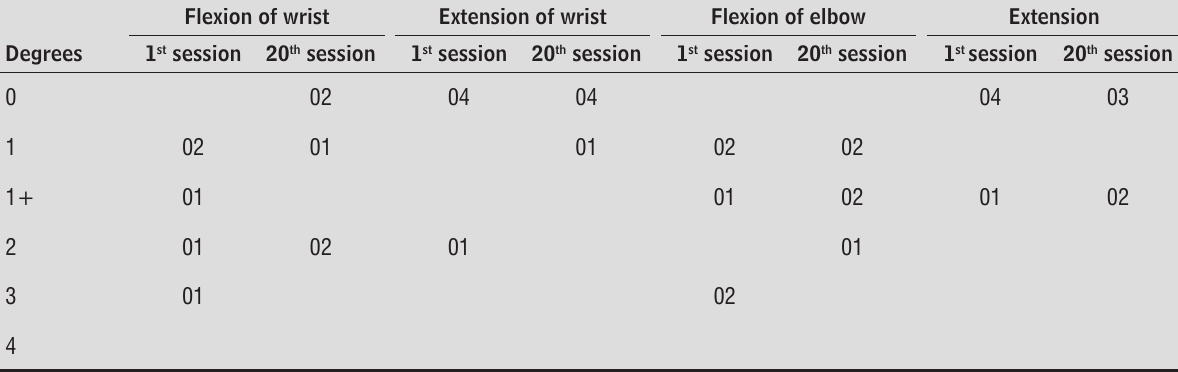
Table 2 - Distribution of the number of patients according to the degree of spasticity at the beginning and at the end of the